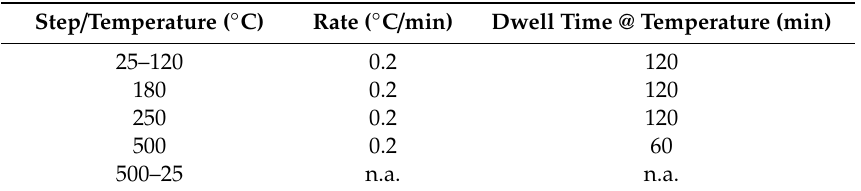
Table 2. Thermal debinding parameters.